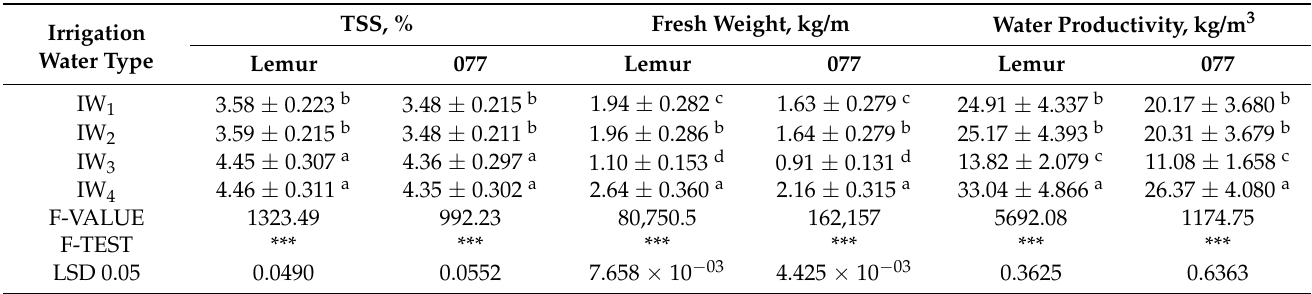
Table 2. Effects of common irrigation water, magnetically treated common irrigation water, saline wa- ter and magnetically treated saline water on total soluble solids, fresh weight and water productivity of both investigated iceberg lettuce cultivars.